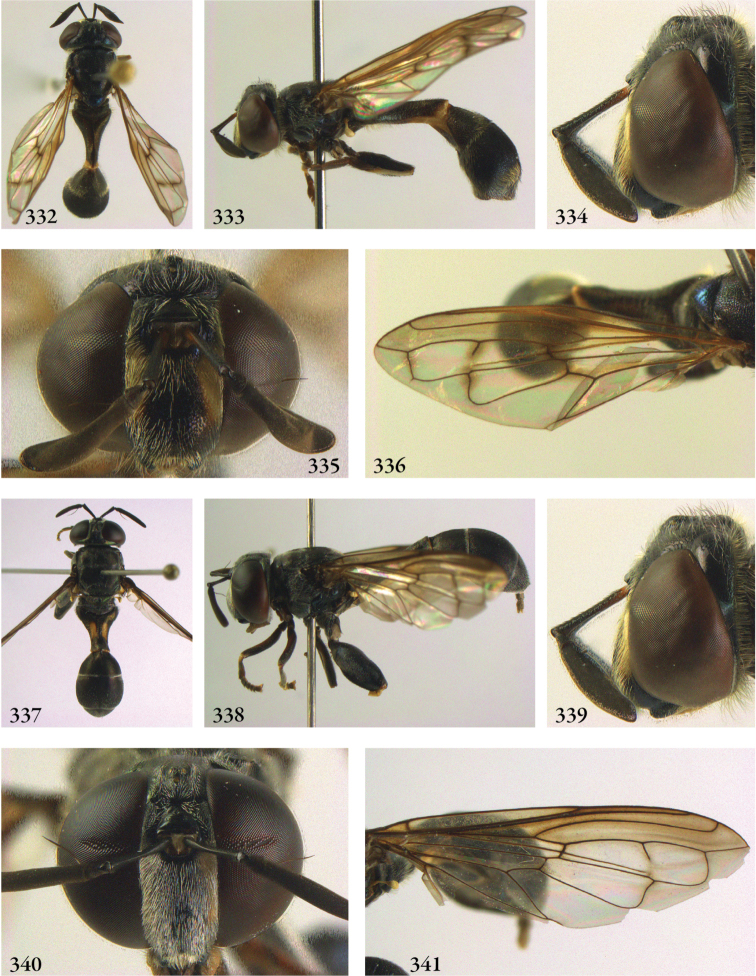
332–336
Rhopalosyrphus ecuadoriensis male (holotype): 332 habitus dorsal 333 habitus lateral 334 head lateral 335 head frontal 336 wing 337–341
Rhopalosyrphus robustus female (holotype) 337 habitus dorsal 338 habitus lateral 339 head lateral 340 head frontal 341 wing.